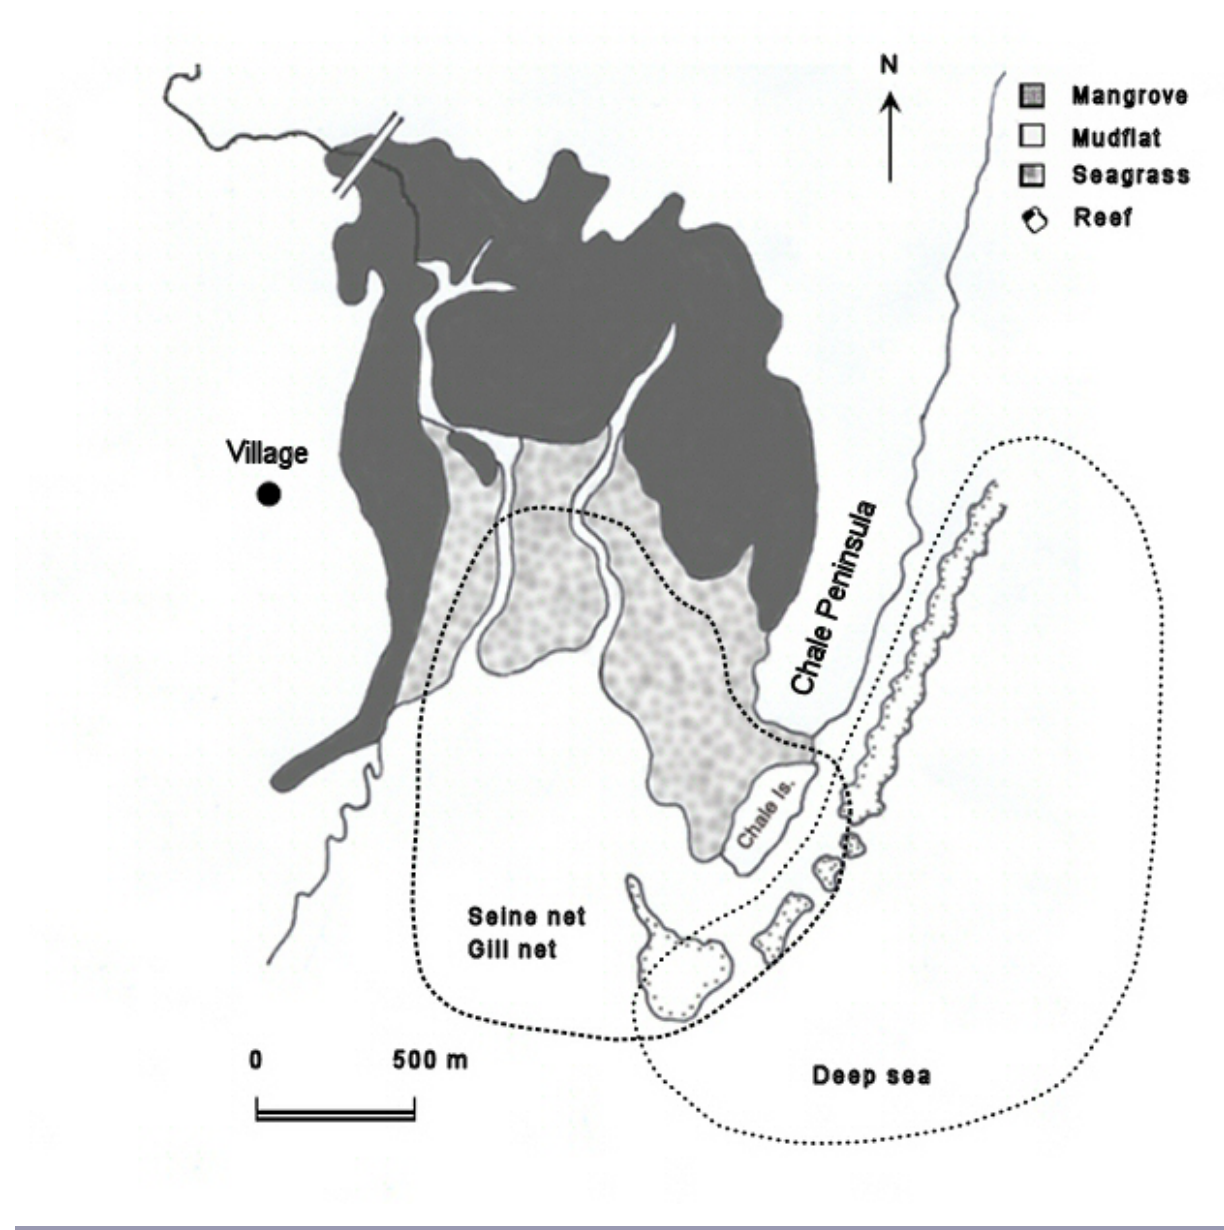
Fig. 2. Map of the coastal seascape in focus. The respective distribution of mangroves, mudflats, seagrass beds, and reefs is indicated. The area of primary fishing effort for each fishing related occupational category is marked with dotted lines showing the geographical distribution of fishing areas at a local scale. The occupational categories associated with each area are indicated in the